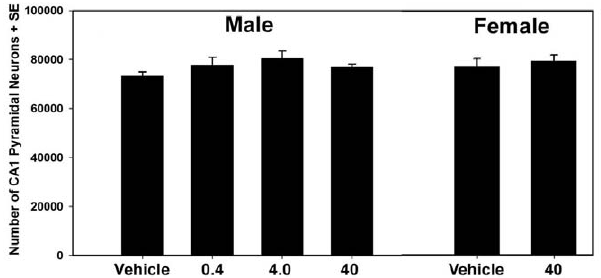
Figure 4. Number of hippocampal CA1 pyramidal neurons across treatment groups and sex. Four treatment groups (i.e. vehicle, 0.4, 4.0 & 40 m g/kg misoprostol, s.c.) were analyzed for male mice, and two treatment groups, the vehicle and high 40 m g/kg dose group, were analyzed for females. No significant treatment effects, sex differences or sex by treatment interaction were